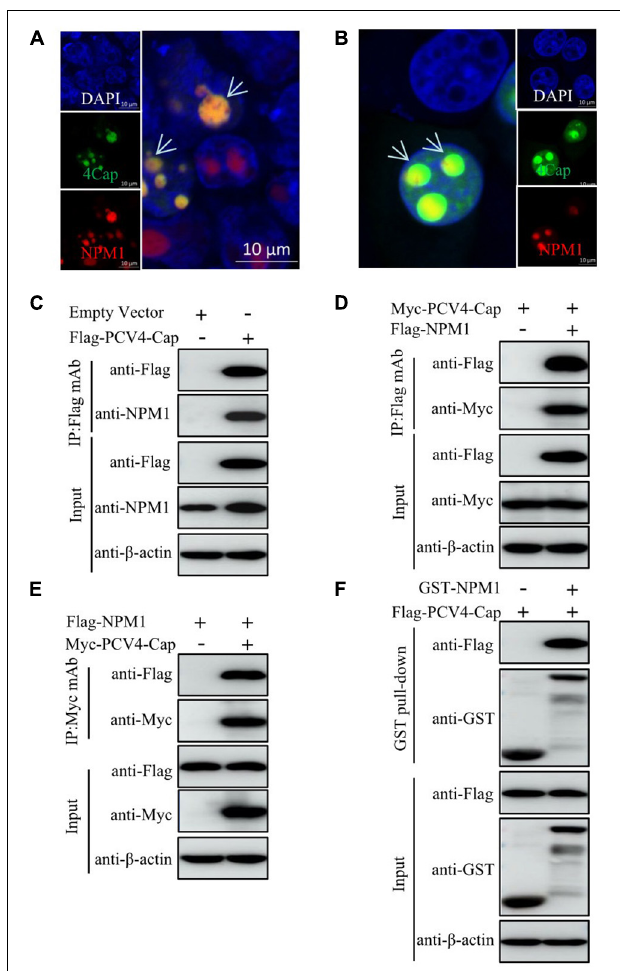
FIGURE 2 | PCV4 Cap binds to NPM1. (A,B) Colocalization of NPM1 with PCV4 Cap in co-transfected cells. HEK293T cells (A) or PK-15 cells (B) were co-transfected with GFP-PCV4-Cap and mCherry-NPM1 for 24 h, and the cells were fixed followed by nuclei staining with DAPI (A,B) . Scale bar, 10 µ m. (C) PK-15 cells were co-transfected with an empty vector and Flag-PCV4-Cap for 48 h. (D,E) The cell lysate extracts were immunoprecipitated with Flag beads (C,D) or anti-Myc purified IgG (E) . (F) The Flag-PCV4-Cap-transfected HEK293T cell lysates mixed with the GST, and GST-NPM1 proteins subjected to a GST pull-down assay and then detected by western blotting using corresponding